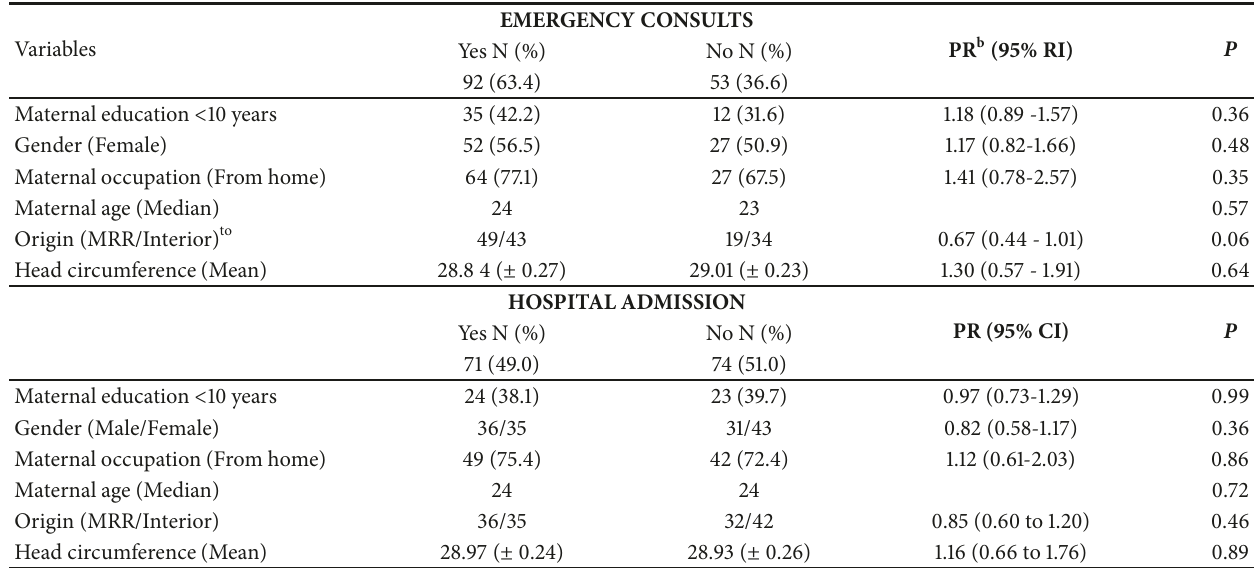
Table 2: Univariate analysis of the possible factors associated with emergency visits and hospitalization in patients with SCZV. Institute of Integral Medicine Prof. Fernando Figueira, August 2015 to October